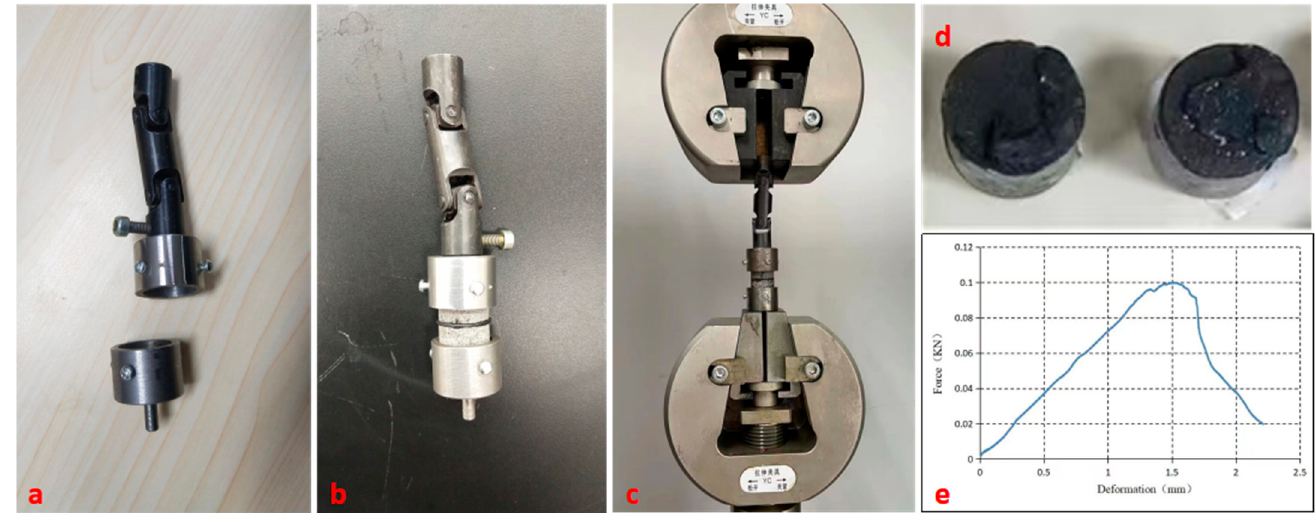
Figure 3. Testing of asphalt mastic–aggregate interface specimens: ( a ) holding fixture; ( b ) specimen fixed by holding fixture; ( c ) specimen fixed into universal testing machine; ( d ) specimen failure surface; ( e ) loading